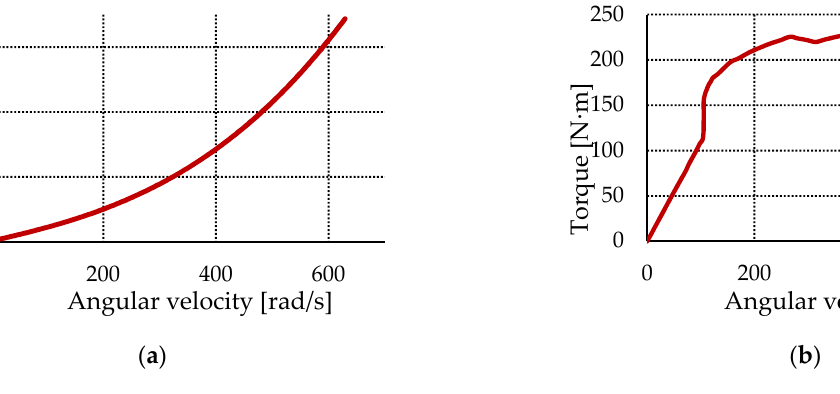
Figure 2. Waveform of instantaneous values [75]: ( a ) torque losses as a function of engine crankshaft angular velocity of the 2018 Toyota Camry LE vehicle; ( b ) maximum engine crankshaft torque as a function of engine angular velocity of the 2018 Toyota Camry LE vehicle.